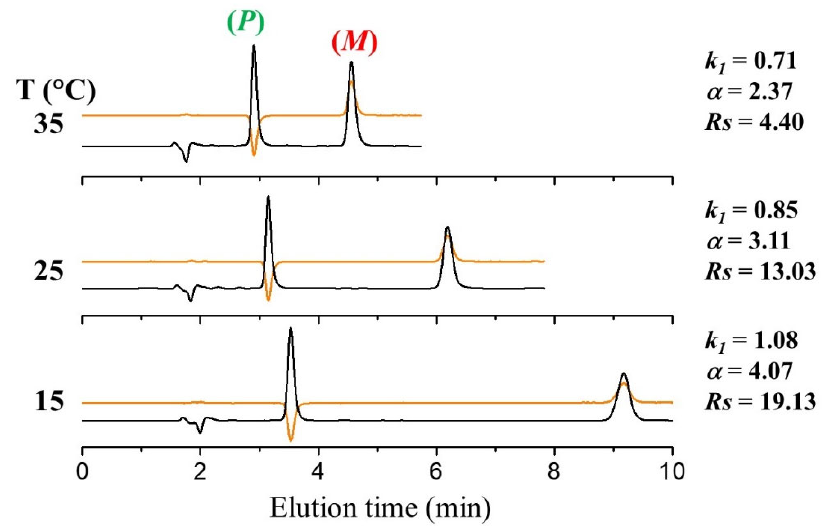
Figure 2. Chromatograms illustrating the effect of column temperature on retention, enantioseparation, and resolution. Chromatographic conditions: column, Chiralpak IB-3 (100 × 4.6 mm, 3 µ m); mobile phase, n -hexane–methanol–dichloromethane 90:5:5 ( v / v / v ); column temperature, as indicated in figure; flow rate, 1.0 mL min − 1 ; detection, UV (black) and CD (orange) at 380 nm.